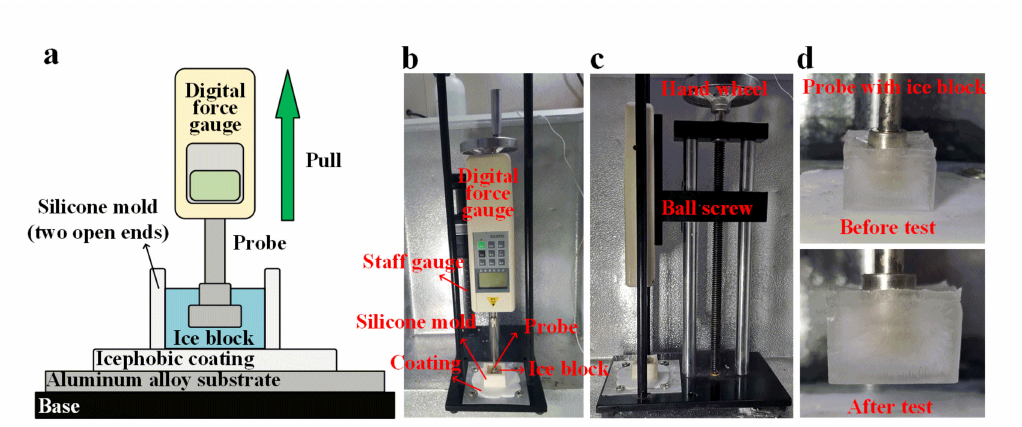
Figure 5. Ice tensile adhesion strength test apparatus. ( a ) schematic diagram; ( b ) real apparatus; ( c ) side view of the apparatus;( d ) the probe with ice block before and after the